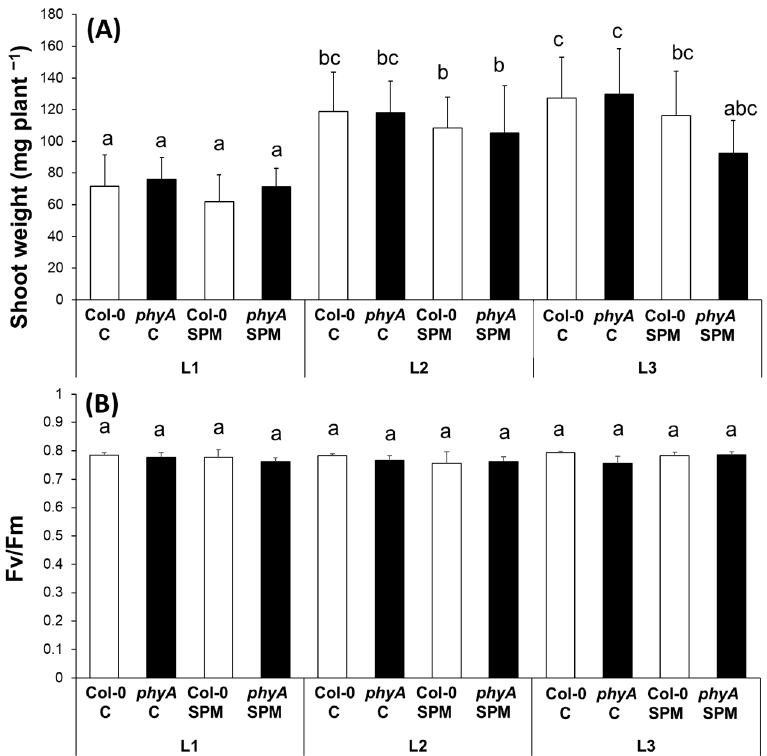
Figure 1. Shoot weight ( A ) and the maximum quantum efficiency of photosystem II (Fv/Fm) chlorophyll-a fluorescence induction parameter determined at the steady state level of photosynthesis of the leaves ( B ) of wild type (Col-0) and mutant ( phyA ) Arabidopsis plants grown under three different light regimes (L1: blue%: 19.139, green%: 30.62, red%: 48.8 and far-red%: 1.44; L2: blue%: 19.57, green%: 29.57, red%: 40.43 and far-red%: 10.43; L3: blue%: 39.38, green%: 28.76, red%: 30.53 and far-red%: 1.33) treated with or without 0.5 mM spermine (control: C and spermine: SPM). Values are means ± SD (n = 14 for shoot weight and n = 5 for Fv/Fm). Different letters indicate statistically signi fi cant di ff erences at p < 0.05 level, using Duncan’s post hoc test.